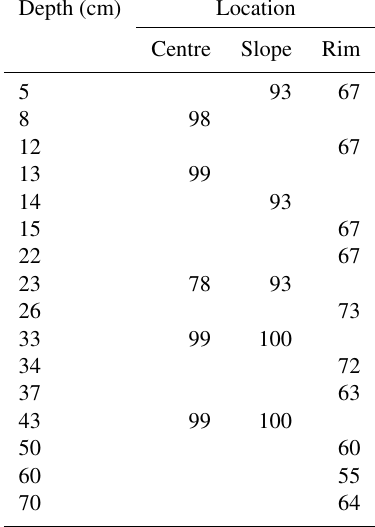
Table C1. Porosity values for different depths and locations used for the calculation of volumetric liquid water content. Values were estimated using measured laboratory values, soil texture/horizon characteristics and TDR values at maximum saturation